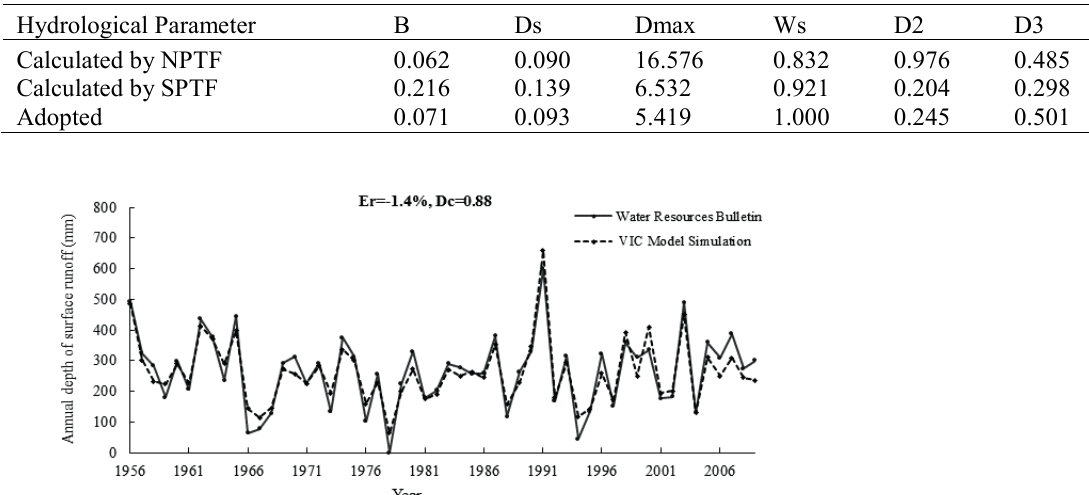
Table 1 Regional average parameters of each scheme.